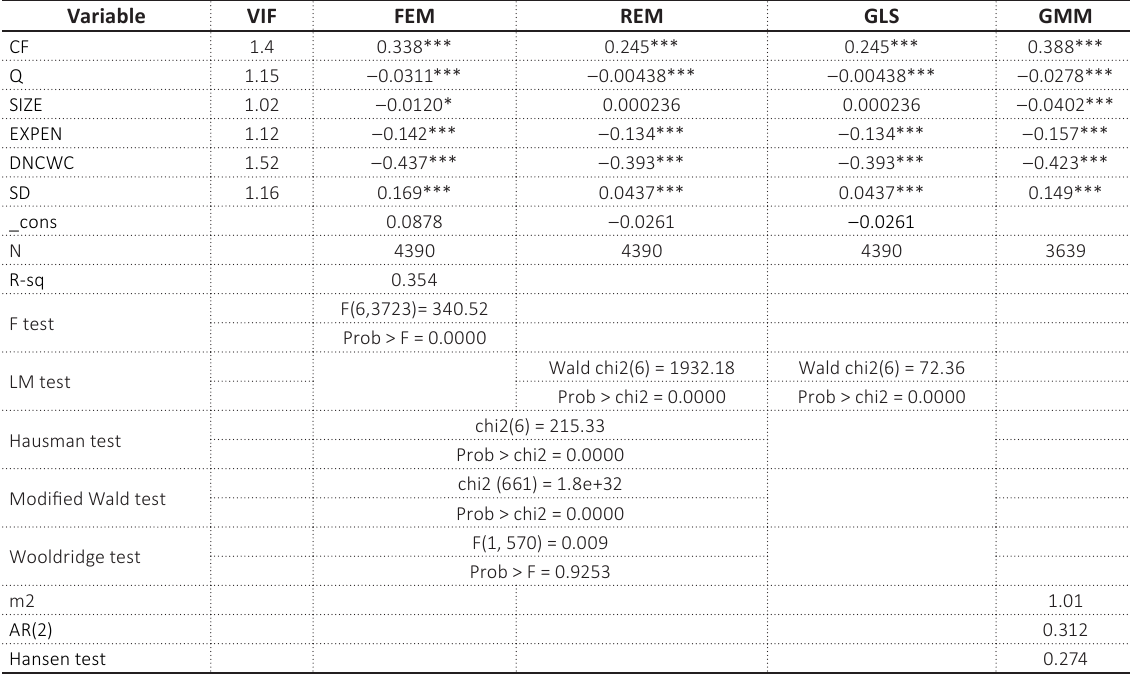
Table 4. Regression results of model 1